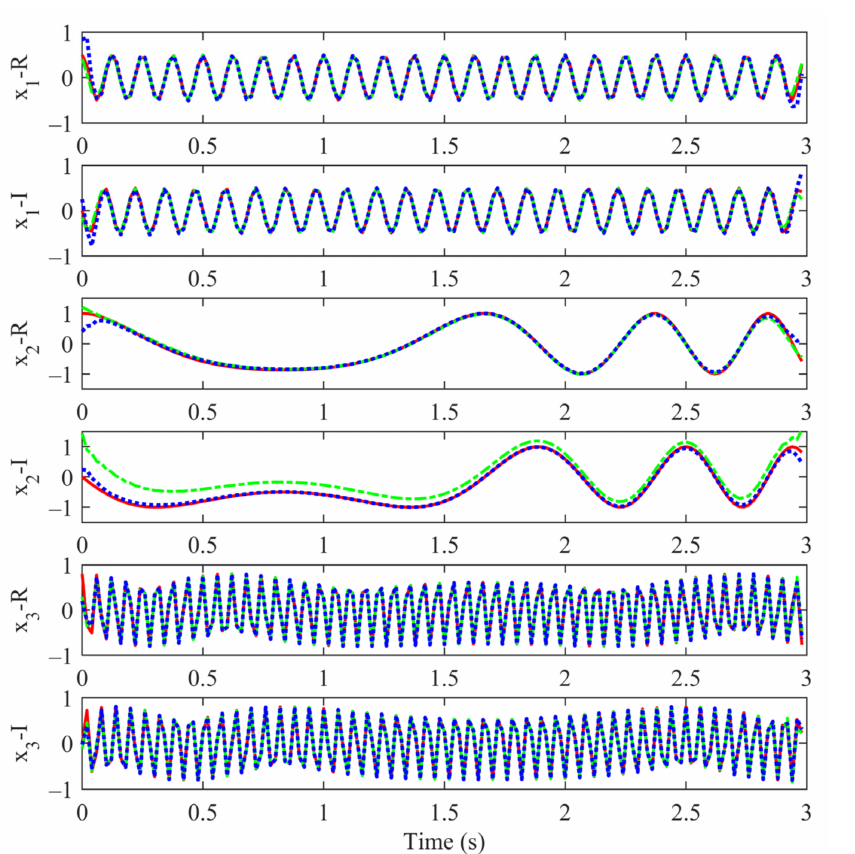
Figure 5. The original signal (red solid line), CVMD decomposed modes (green dash-dot line), and MCVMD decomposed modes (blue dotted line). From top to bottom: the real part of x 1 , the imaginary part of x 1 , the real part of x 2 , the imaginary part of x 2 , the real part of x 3 , and the imaginary part of x 3